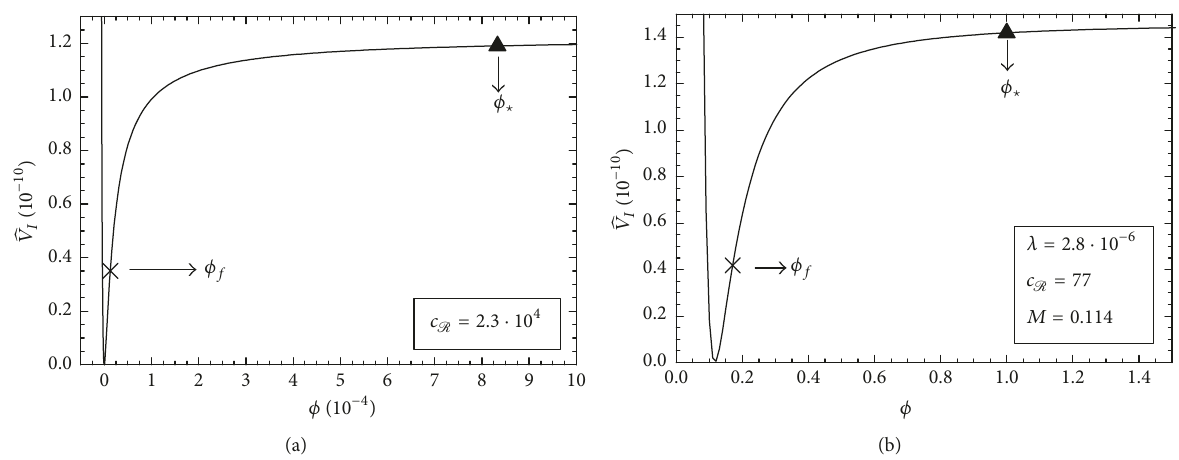
̂𝑉 𝐼 as a function of